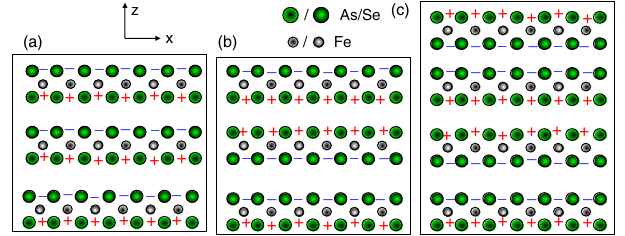
FIG. 6. Sketch of a real-space sign distribution along the c axis for an (cid:1) -pairing state in (a) an 11-type structure, (b) a 122-type structure with an odd number of layers, and (c) a 122-type structure with an even number of